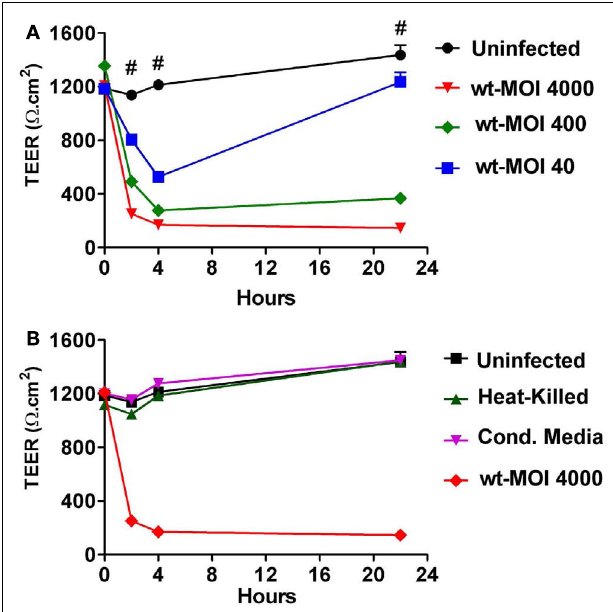
FIGURE 1 |Trans-epithelial electrical resistance (TEER) responses of CaCo2 cell monolayers to wild-type S .Typhi, HK bacteria, and culture supernatants. (A) TEER changes upon infection with wild-type S .Typhi at different MOIs. (B) TEER in HK bacteria and culture supernatants (Cond. Media) treated monolayers. Data are expressed as means ± SEM for triplicate samples for all conditions tested.These results are representative of three experiments with similar results. #Denotes p < 0.001 of S .Typhi strains over t = 0